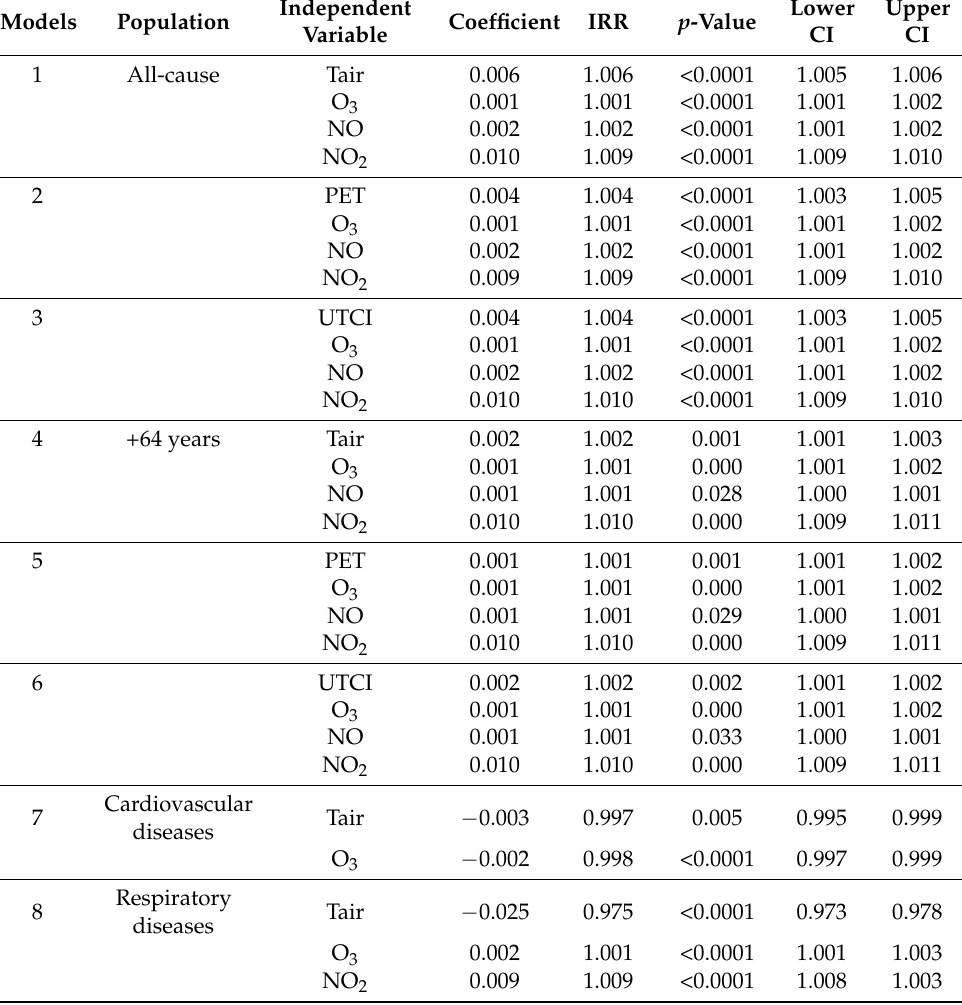
Table 3. Negative binomial regression models for the impact of the thermal environment on the number of hospital admissions (dependent variable). All models are adjusted for admission year and hospital.